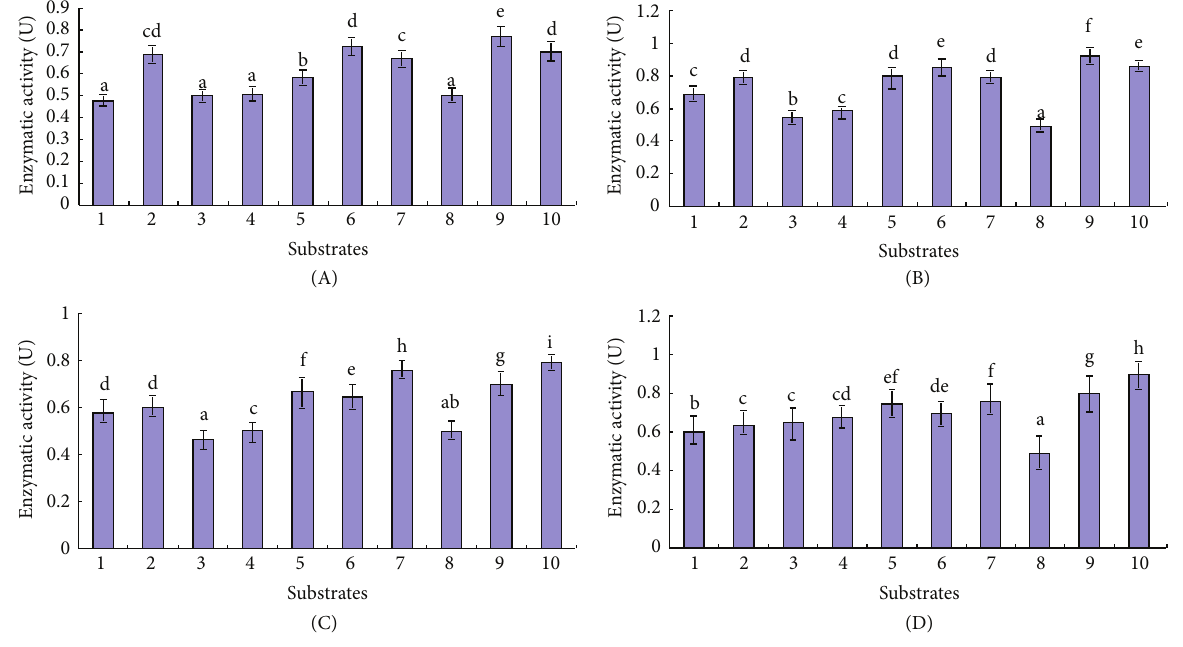
Figure 5: The activities of four different recombinant chitinases on various substrates. (A) Activities of recombinase inrCHI31 to various substrates; (B) activities of recombinase exrCHI31 to various substrates; (C) activities of recombinase inrCHI32 to various substrates; (D) activities of recombinase exrCHI32 to various substrates. One percent (w/v) of substrate was dissolved in 0.02 molL −1 HAc-NaAc buffer (pH 4.5) as reaction solution. Subsamples of the reaction solution were collected and used to measure chitinase activity. Substrates: 1, N.O- carb-chitin; 2, colloidal chitin; 3, chitosan; 4, N.O -carb-chitosan; 5–10, cell wall chitin of S. sclerotiorum, F. oxysporum, R. solani, P. sojae, A. alternata, and V. sordida . The experiments were performed three times. Different letters above the columns indicated a significant difference determined by Duncan’s multiple comparisons test ( 𝑃 < 0.05